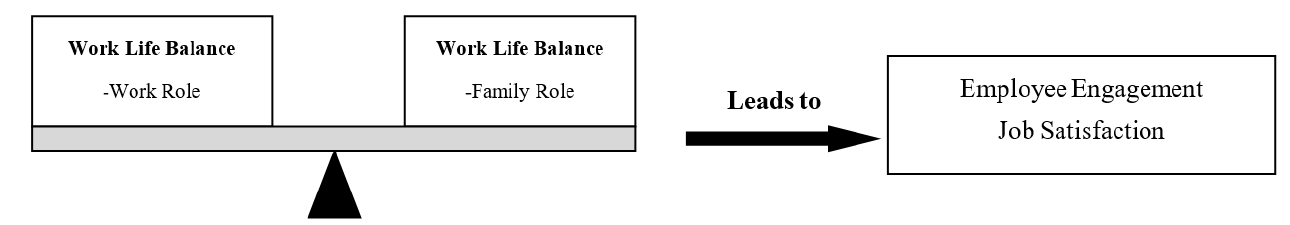
Figure 1. Theoretical assertions derived from role behavior perspective. Source: authors’ own processing.